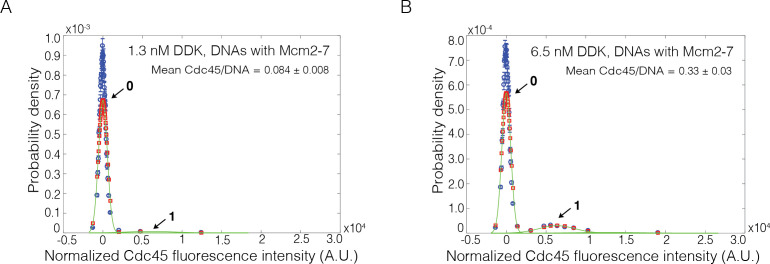
Reducing fraction of labeled Cdc45 results in the detection of individual binding events.(A, B) Cdc45-Mcm2-7-GINS formation assays were performed with 3.6% of Cdc45 molecules being fluorescently labeled. Cdc45SORT649 fluorescence-intensity histograms (blue) are shown. The histogram data were fit to a sum-of-Gaussians model (red; see Materials and methods). Fit parameters and calculated area fractions of individual Gaussian components (green) corresponding to the presence of the indicated numbers of Cdc45SORT649 molecules are given in Supplementary file 1a. The mean (± SE) numbers of Cdc45 molecules per DNA are calculated from the fit parameters and the fraction Cdc45 labeled. (A) Reactions with 1.3 nM Dbf4-dependent kinase (DDK) on Mcm2-7-bound DNA molecules. (B) Reactions with 6.5 nM DDK on Mcm2-7-bound DNA molecules.